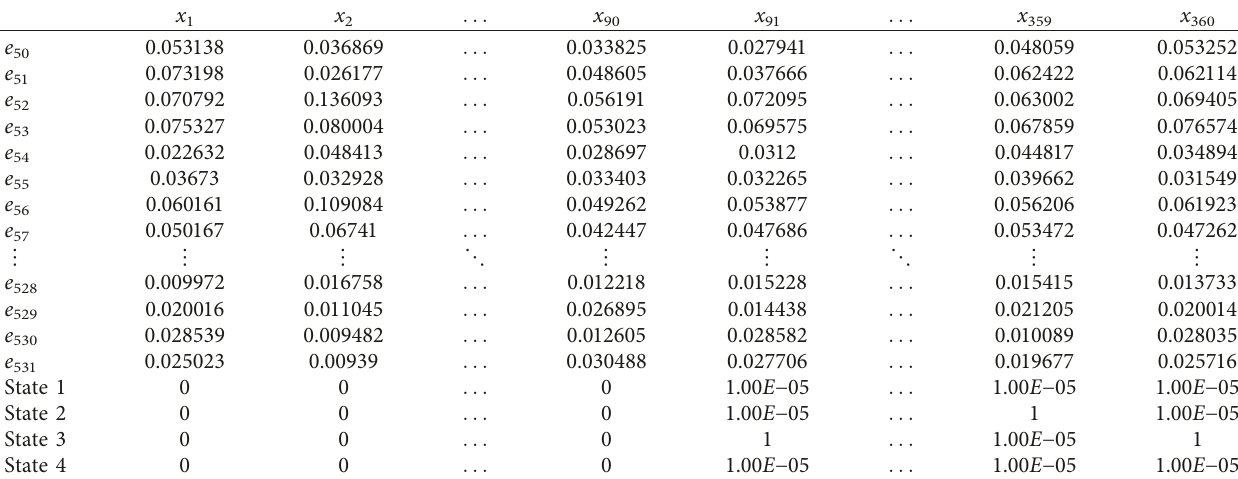
Table 8: Joint score for cross-validation set bearing status identification.